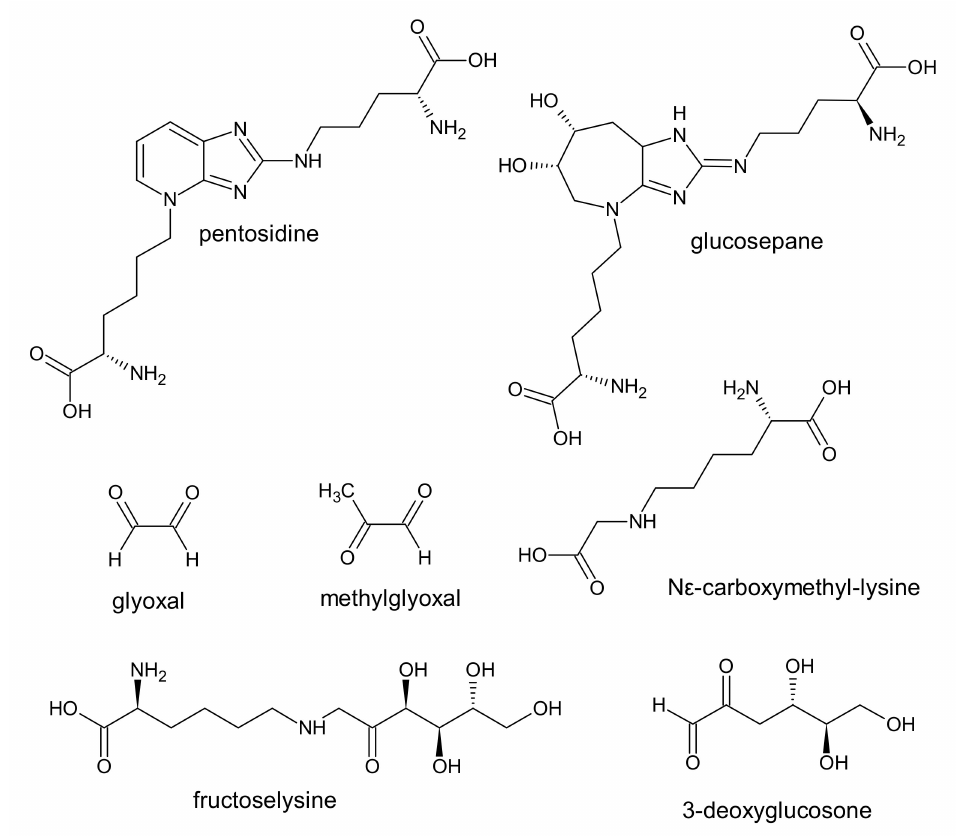
Figure 3. Chemical structure of some AGE, classified as protein-binding uremic